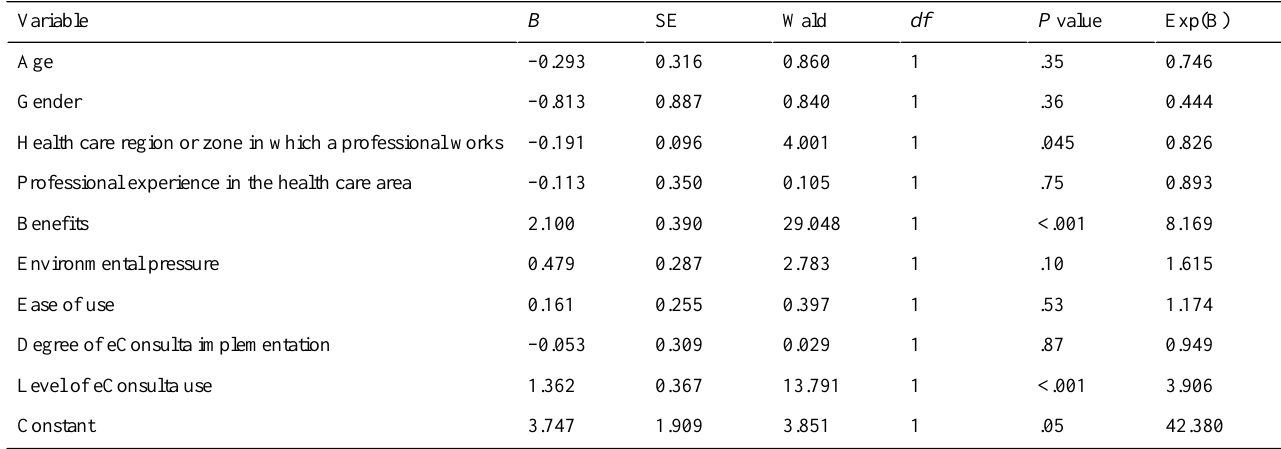
Table 5. Logistic regression on eConsulta predictors